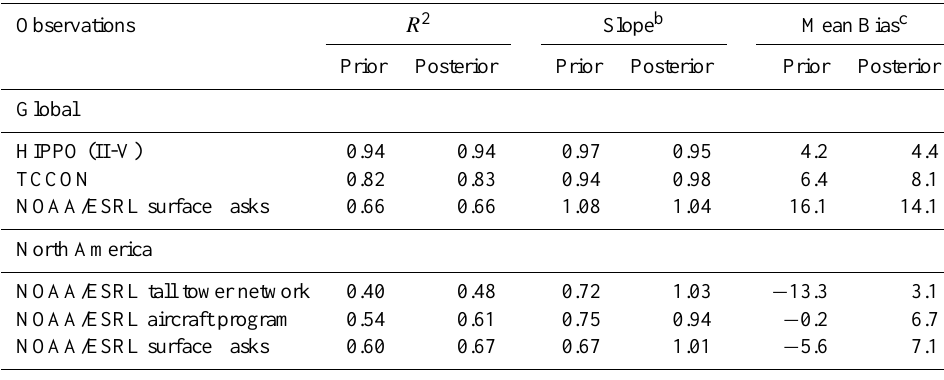
Table 2. GEOS-Chem comparison to 2009–2011 suborbital methane observations a .